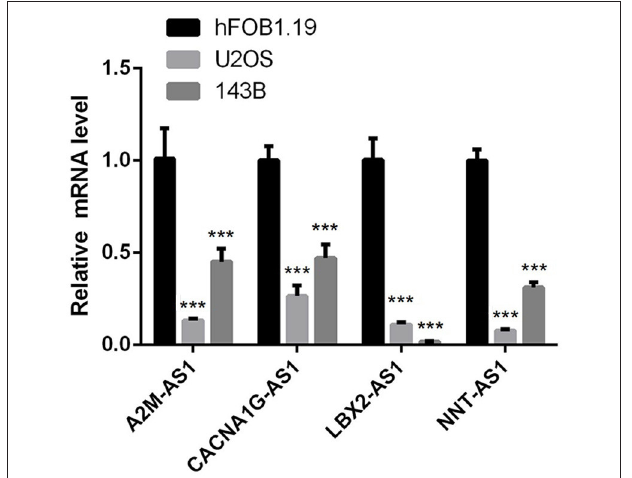
FIGURE 5 | qRT-PCR was used to detect the expression of lncRNA in human osteoblast and osteosarcoma cells in 4-epi-lncRNA signature. (*P < 0.05, ** P < 0.01, *** P < 0.001, **** P <